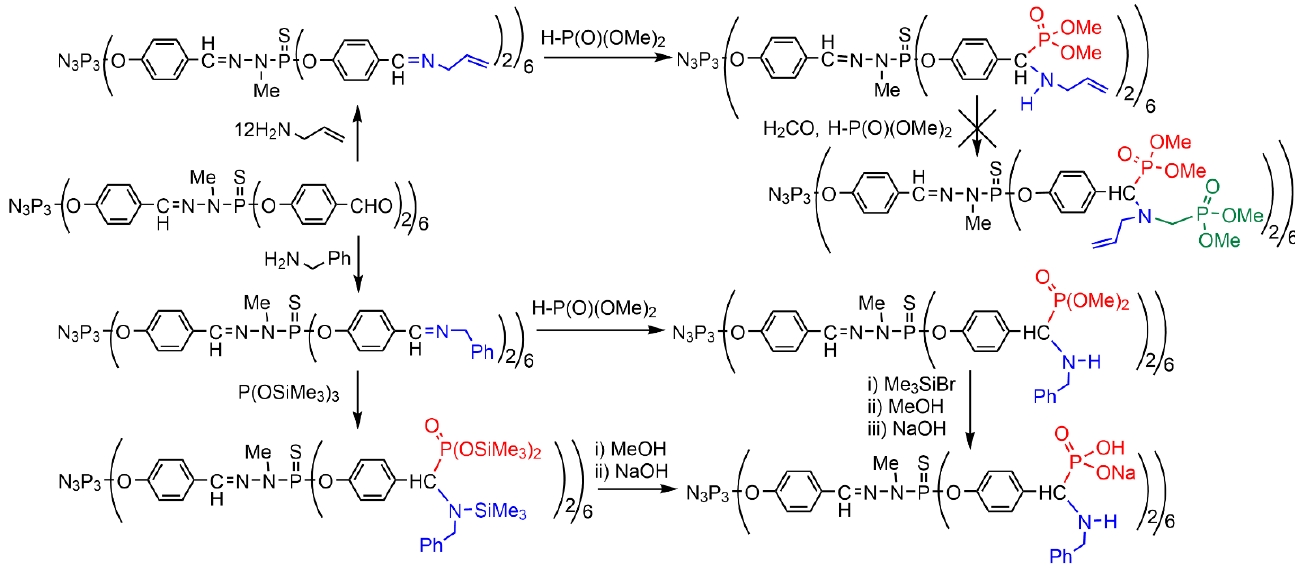
Scheme 13. Two-step processes from aldehydes, affording phosphonate and secondary amines as terminal functions of PPH dendrimers. They display poor anti-inflammatory